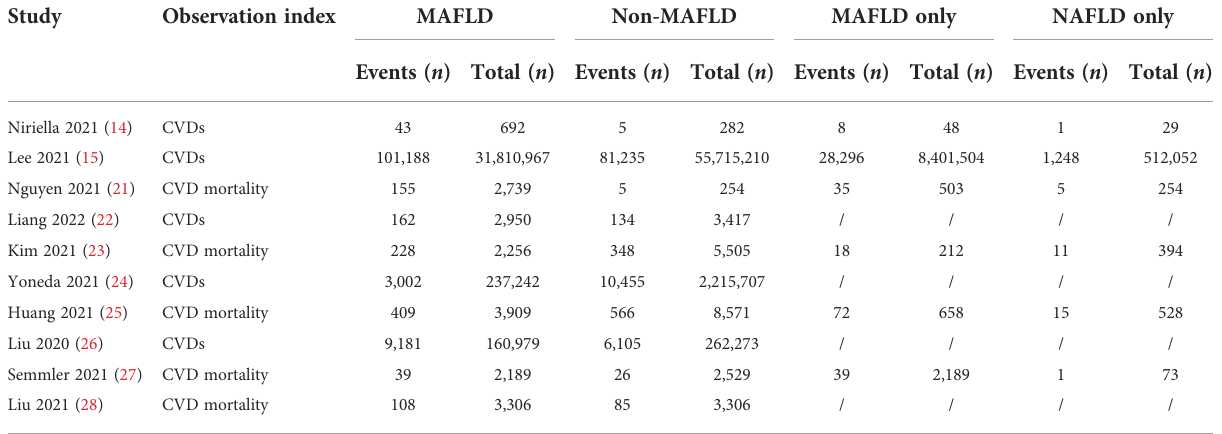
TABLE 1 Basic information of the included